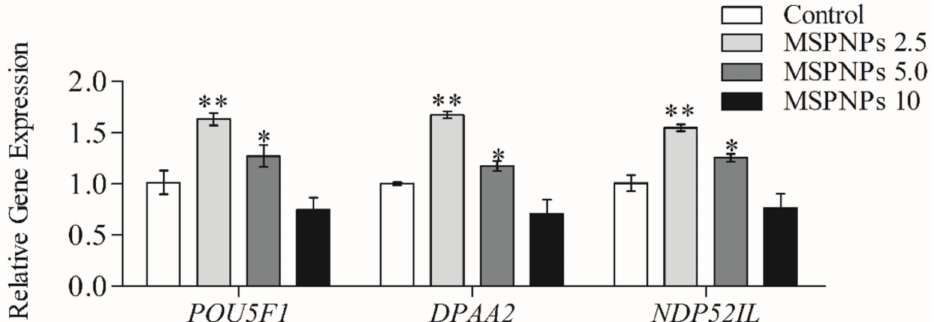
Figure 2. Relative expression of POU5F1 , DPPA2 , and NDP52 mRNA transcripts in cloned blastocysts obtained from oocytes supplemented with varying concentrations of MSmPNPs (0, 2.5, 5.0, and 10 µ g/mL) in maturation media. Each sample consisted of five blastocysts and three times replicate. * Indicates that there is a significant difference in mRNA values between each group ( p < 0.05). ** Indicates that there is a significant difference in mRNA values at p <